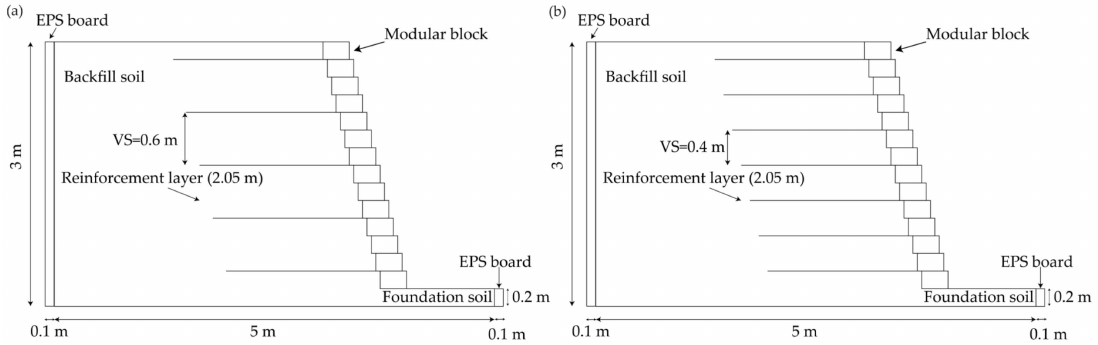
Figure 5. The cross-section of the modular-block geosynthetic-reinforced soil (MB-GRS) wall: ( a ) wall 1; ( b ) wall 2.